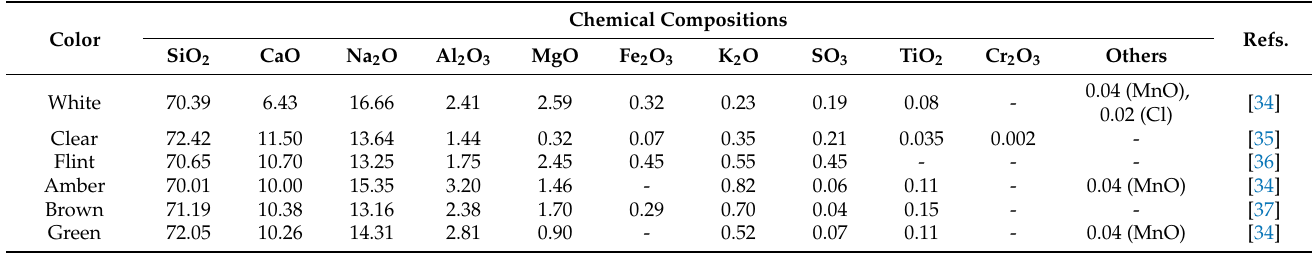
Table 1. Chemical components of glass for various colors.